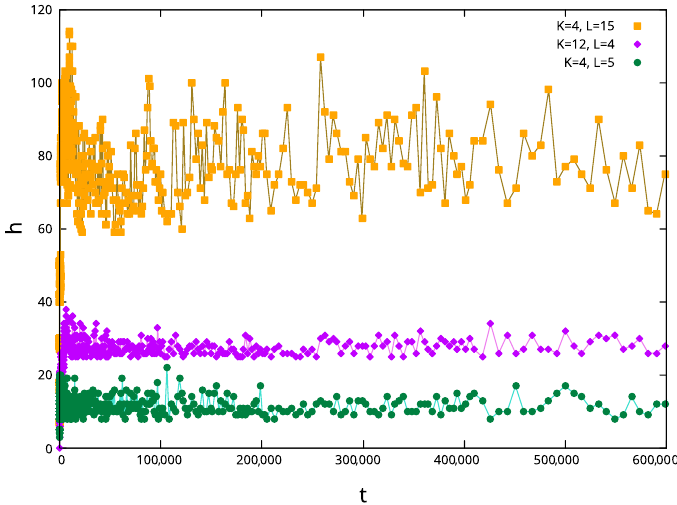
Figure 6. Time evolution of the number of holes ( h ) for N = 10,000 and different values of K and L